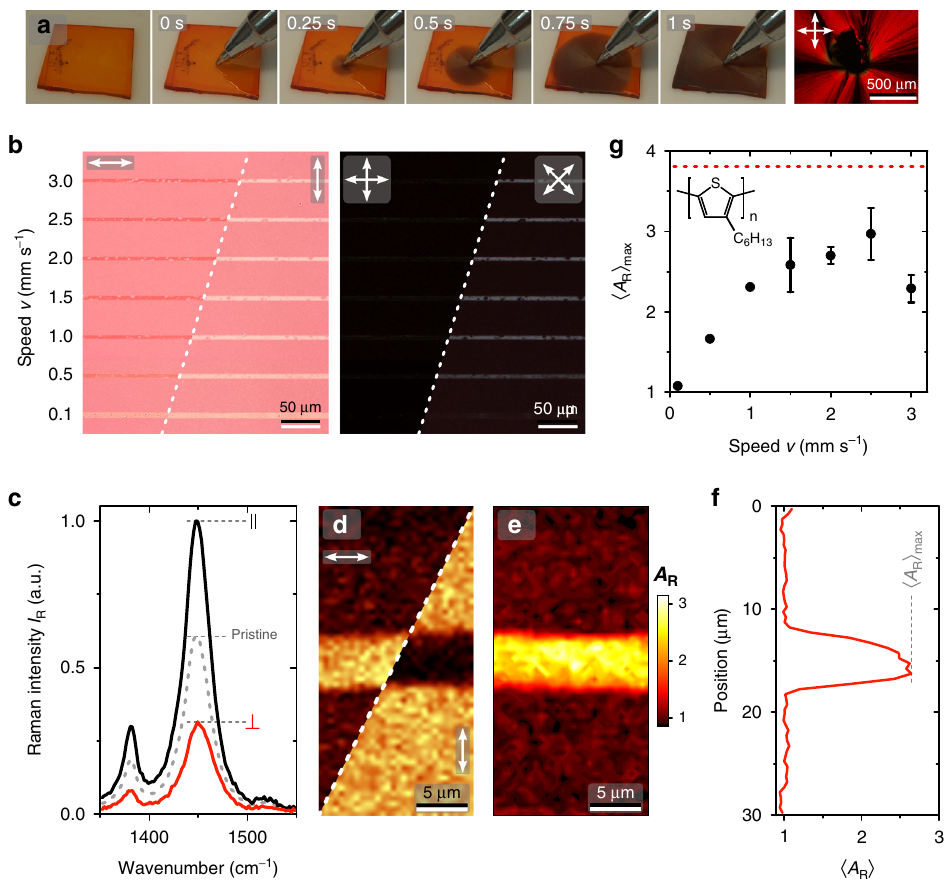
Fig. 3 Chain orientation patterning in P3HT fi lms. a Directional crystallisation of a P3HT : BT fi lm by nucleation with BT. Photographs are shown at the indicated times. Also shown is a cross-polarised micrograph recorded at the centre of the obtained P3HT fi lm following sublimation of BT. b Transmitted- light micrographs of a P3HT fi lm laser-patterned at the indicated writing speeds v . Polarised-incidence and cross-polarised micrographs are shown, with the corresponding relative orientations of polariser transmission axes indicated by the arrows. c – f Exemplary spatially resolved Raman spectroscopy analysis of the line patterned using v = 2.5 mm s − 1 . c Polarised Raman spectra centred on the symmetric C = C stretching mode of the P3HT recorded at the centre of the pattern (black and red lines) and pristine unpatterned area (dotted grey line). d Polarised Raman maps showing maximum intensity I R at ~1450cm − 1 recorded for the indicated excitation/detection polarisations, and ( e ) the corresponding Raman anisotropy image ( A R = I R,|| / I R, ⊥ ). f Average Raman anisotropy 〈 A R 〉 pro fi le across the pattered line. g Maximum values of 〈 A R 〉 as a function of speed v . Dotted red line indicates the corresponding value obtained for a macroscopically oriented fi lm, as in a . Inset shows the chemical structure of